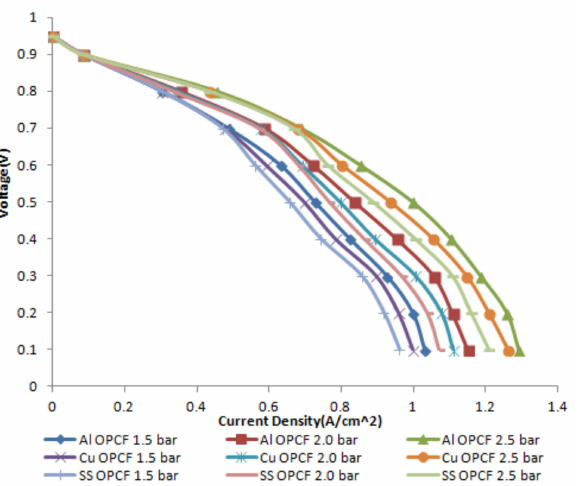
Figure 7. Effect of different operating pressure at 1.5, 2.0 and 2.5 bar polarization